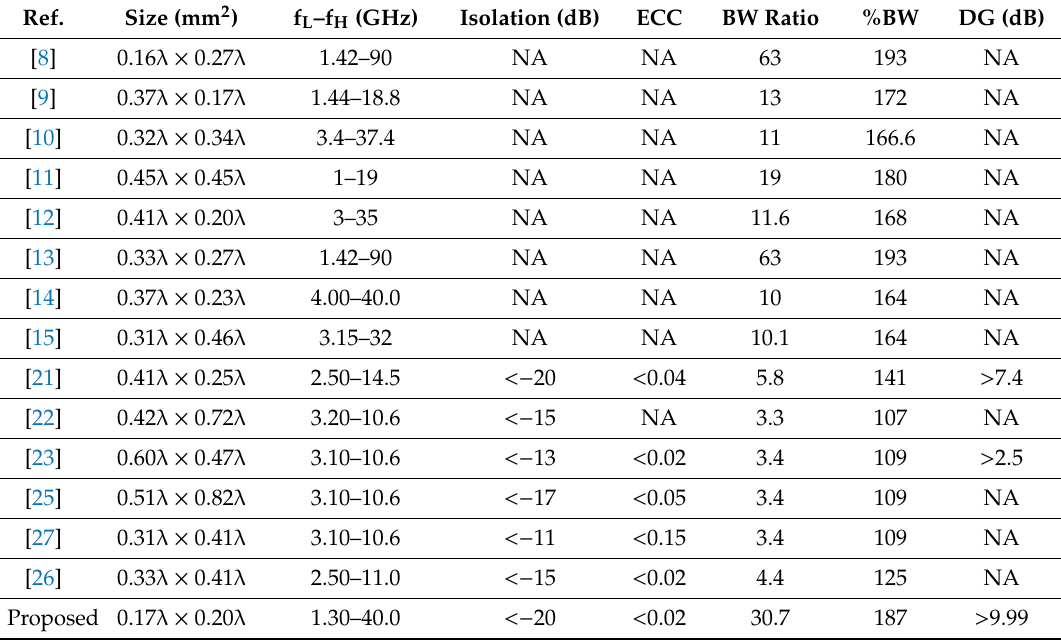
Table 1. Comparison to previously designed MIMO